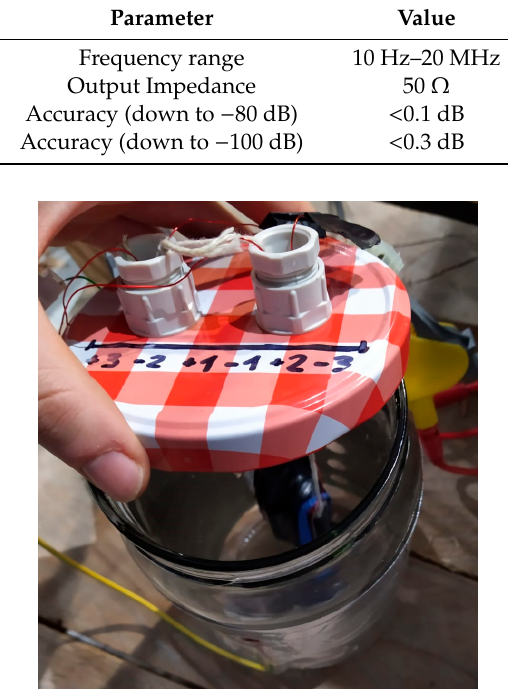
Figure 9. Two-liter container with the fluid core double coil sensor.